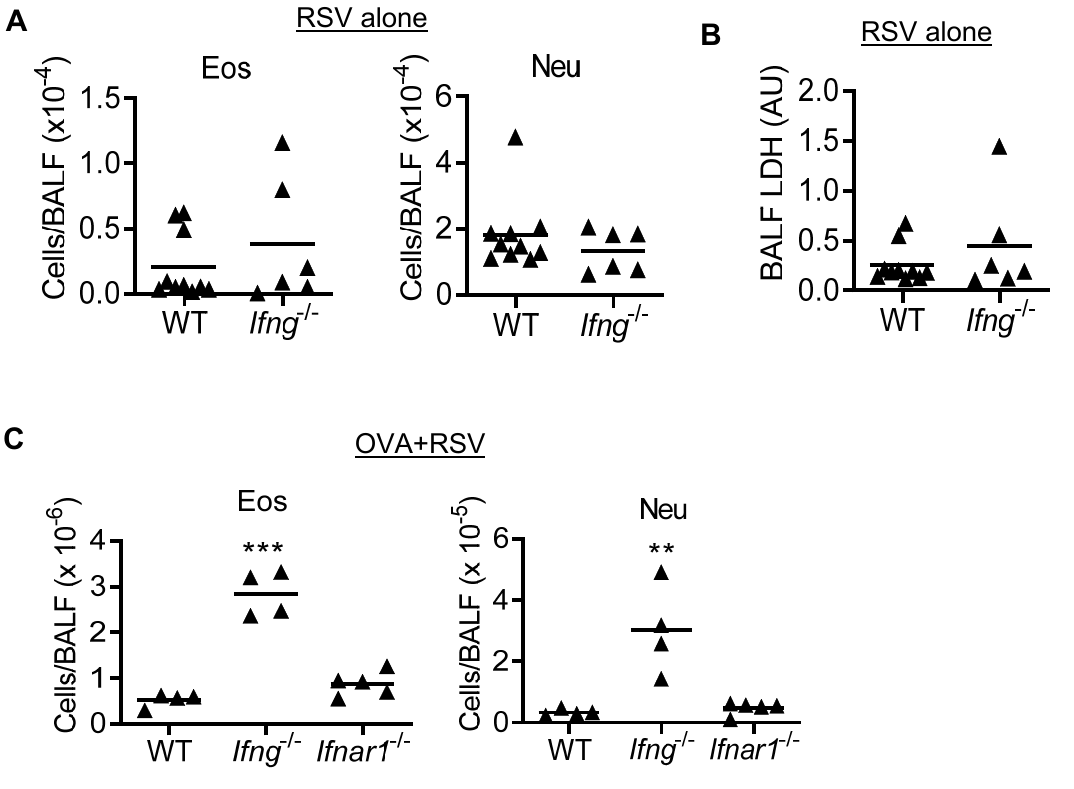
Figure 3. IFN- γ inhibits both eosinophilic and neutrophilic inflammation during RSV infection of OVA-induced asthmatic mice. ( A ) Numbers of eosinophils (Eos) and neutrophils (Neu) and ( B ) LDH levels in the BALF at day 7 after RSV infection of C57BL/6 WT and Ifng − / − mice. ( C ) Numbers of airway eosinophils and neutrophils at day 7 after RSV infection of OVA-induced asthmatic C57BL /6 WT, Ifng − / − , and Ifnar − / − mice. ** p < 0.01, *** p < 0.001, one-way ANOVA with Tukey’s multiple comparisons’ test. Data shown are representative of two independent